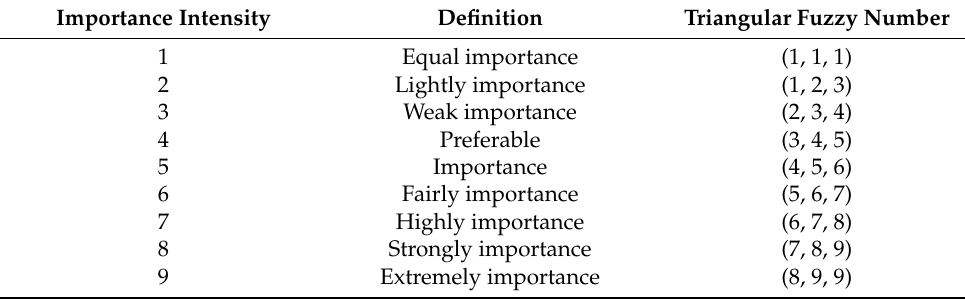
Table 3. Importance intensity and the position of TFN are distributed. Importance